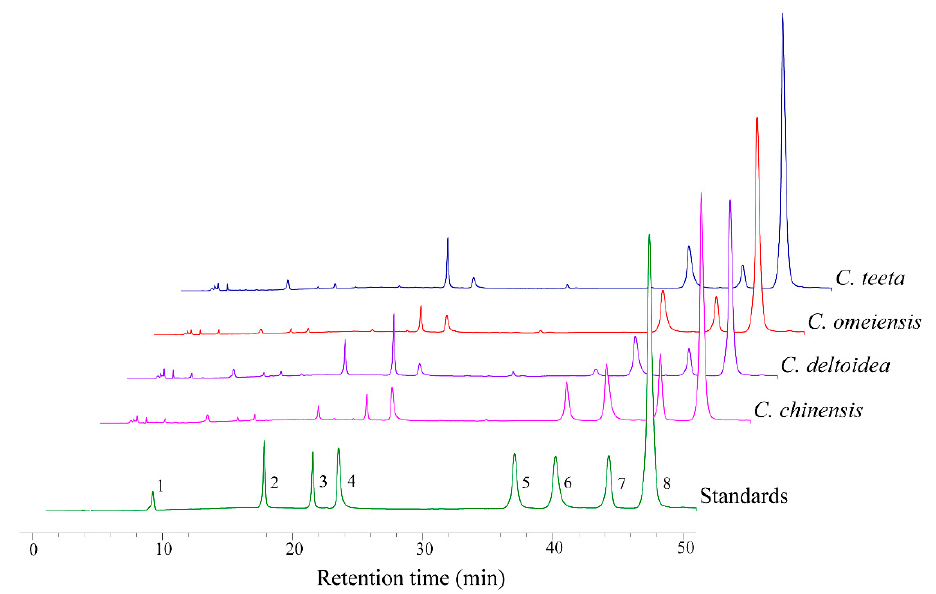
Figure 1. HPLC-UV chromatogram of eight alkaloid compounds in rhizomes separated from different Coptis species (Peaks 1–8 indicate magnoflorine, groenlandicine, jatrorrhizine, columbamine, epiberberine, coptisine, palmatine and berberine, respectively). Table 2. Contents of alkaloid compounds (mg/g) in rhizomes originated from four Coptis plants.